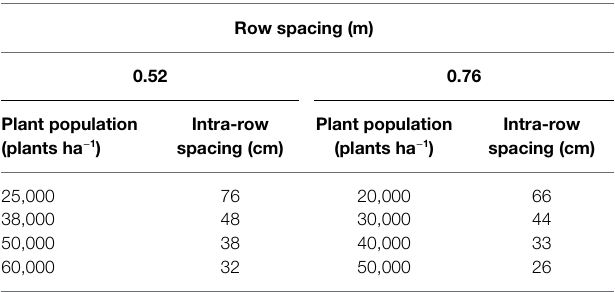
TABLE 1 | Plant population and row spacing configurations and resultant intra- row spacings between plants as